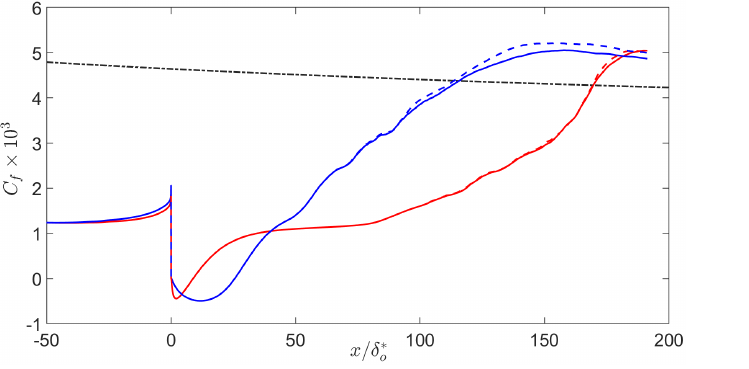
Figure 3. Skin − friction coefficient, C f : Full domain vs. Half domain. , Small step; , large step. The solid line denotes the full domain, the dashed line the corresponding half domain. Turbulent correlation [42].